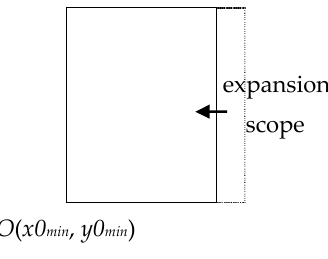
Figure 4. Tile map horizontal expansion.